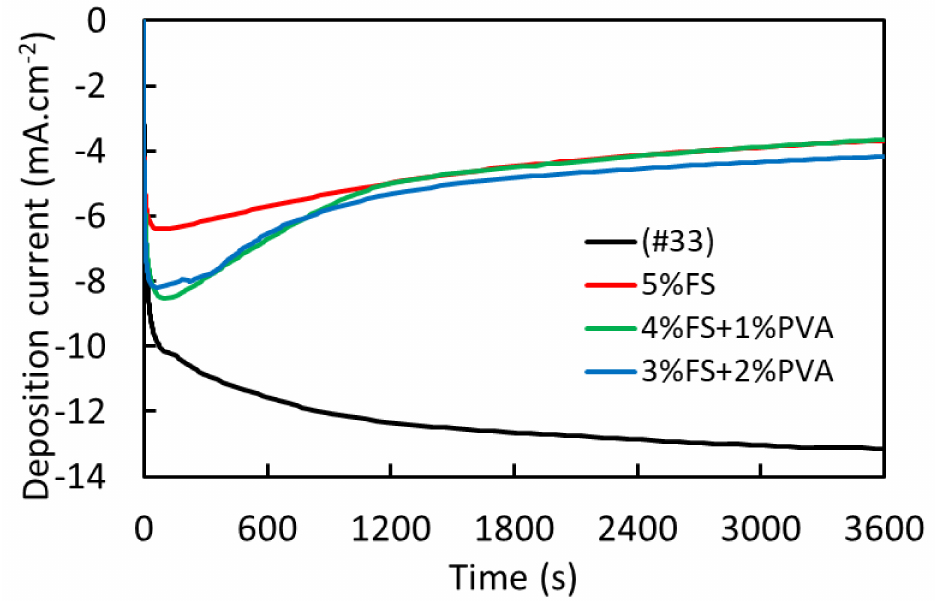
Figure 2. Chronoamperometric current density response observed on the zinc electrode when in contact with different